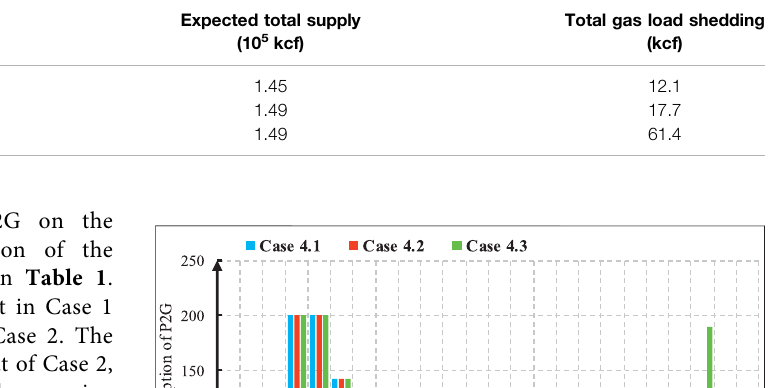
TABLE 2 | Comparison of scheduling results of natural gas systems in different cases.